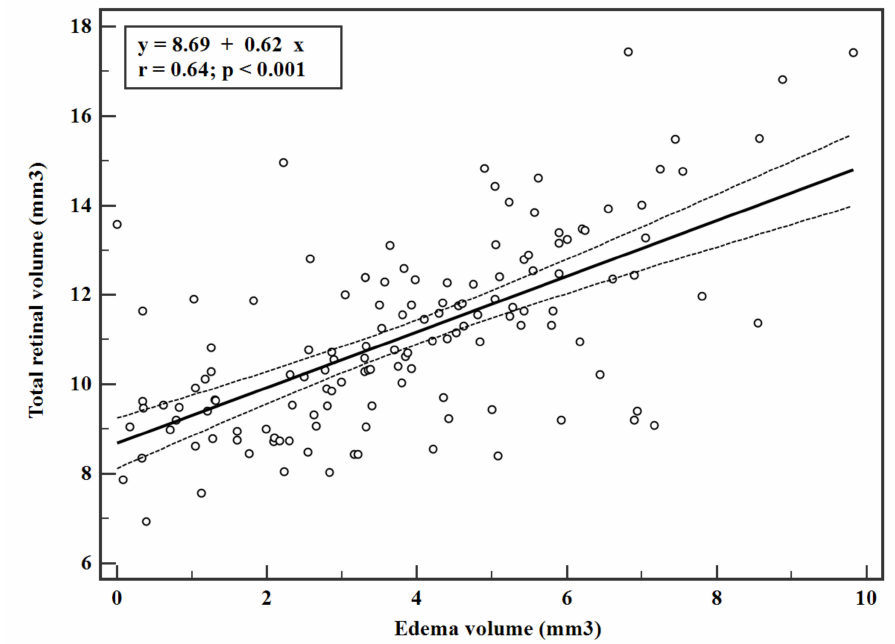
Figure 3. Linear regression with 95% confidence interval between total retinal volume and edema volume. Only eyes with an edema volume greater than zero were included in the regression. Total retinal volume was derived by adding the volumes of all the sectors of the ETDRS